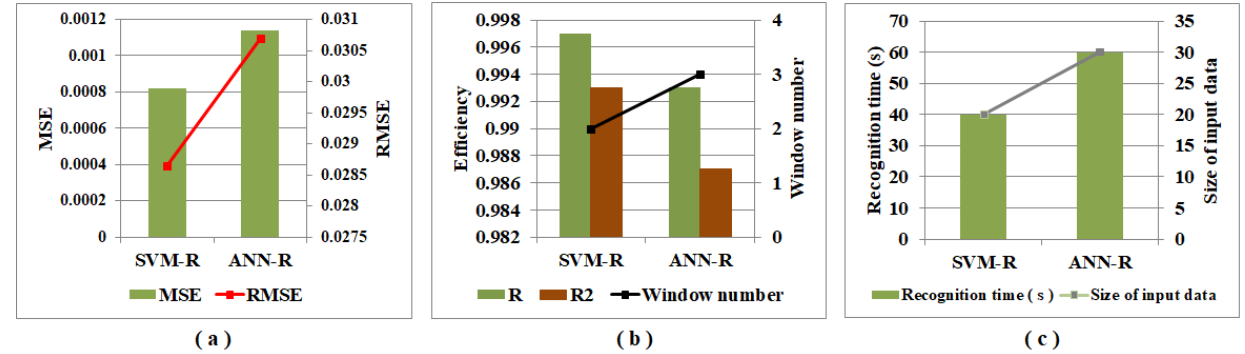
Figure 4. Graphical representation of a comparison of performance metrics ( a ) MSE, RMSE ( b ) R, R2, window number ( c ) recognition time, size of input data of regression models SVM-R, and ANN-R.